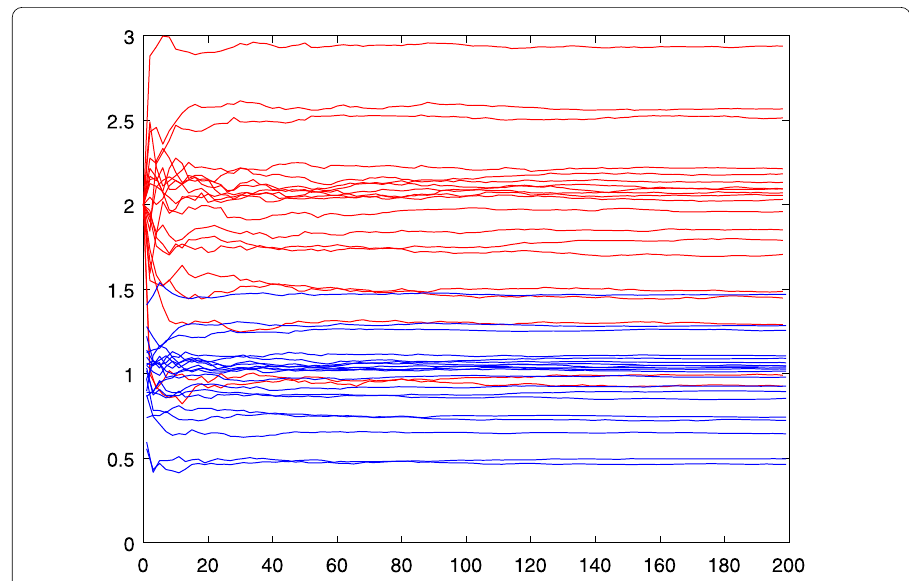
Figure 9 K = 2, a (0) = 1/2, a (1) = 2, ˆ g = 0. Twenty trajectories, showing two random limits for s = 0 (red) and s = 1